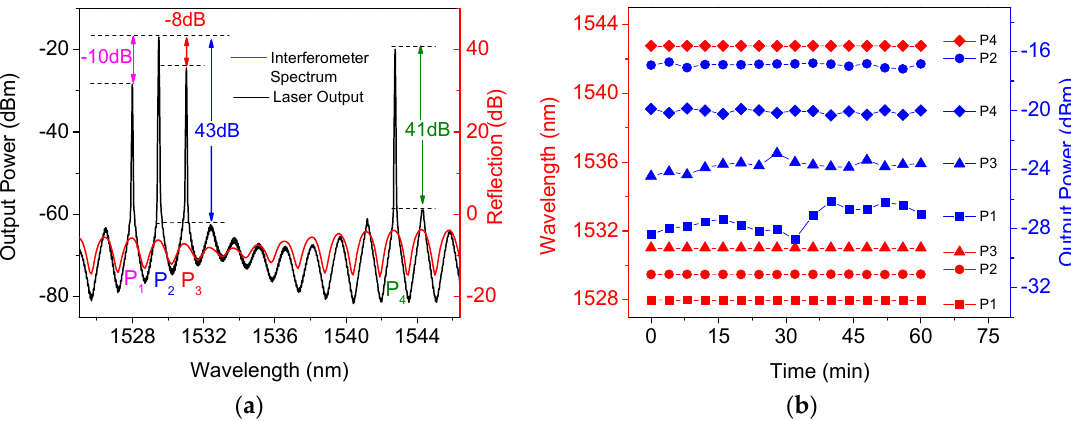
Figure 4. Laser emission: ( a ) Quadruple-wavelength laser emission output for the initial ring cavity configuration (black line). Unequivocal correspondence between the laser emission (black line) and the MFI reflection spectrum (red line); ( b ) One-hour laser emission wavelength stability assessment (red) and power (blue).